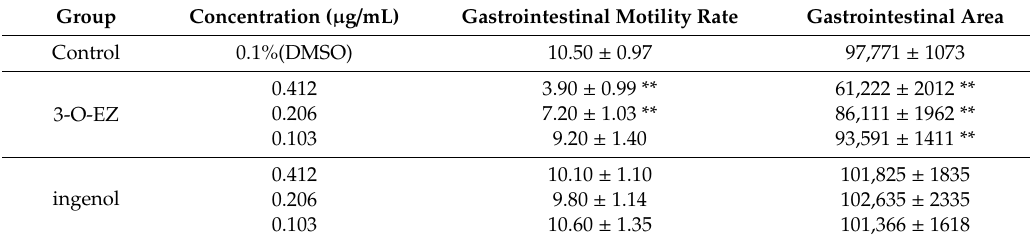
Table 2. The result of gastrointestinal motility rate and area in zebrafish embryos (mean ± SD, n = 10).